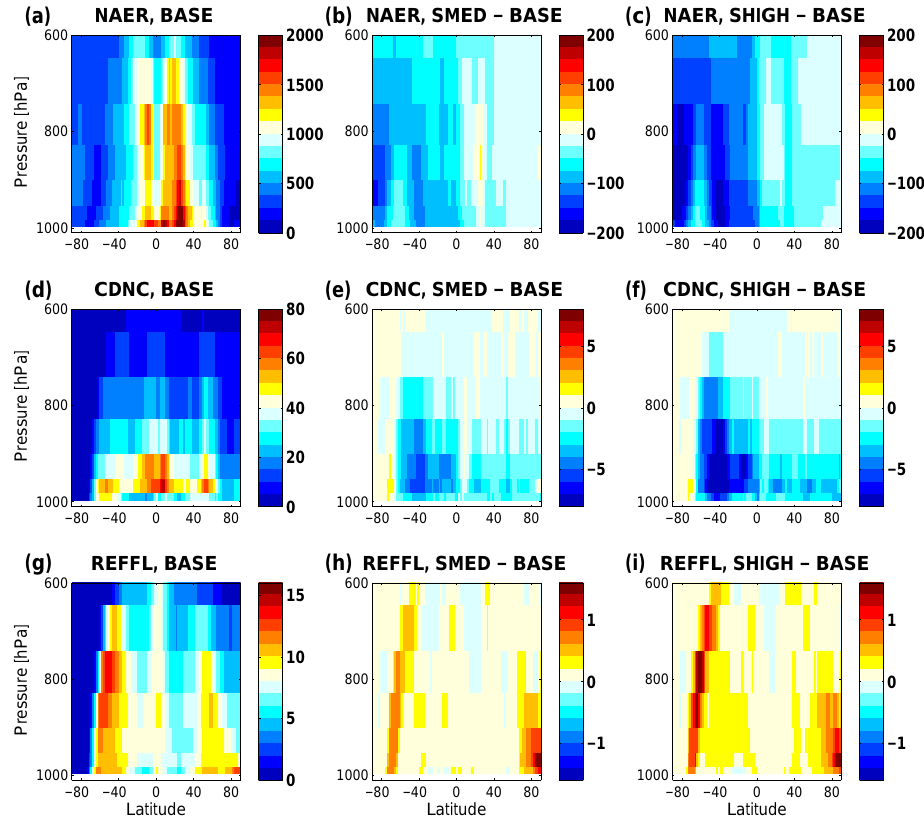
Figure 6. (a) Zonal mean aerosol number concentration ( N aer , cm − 3 ) averaged over the period 2171 to 2200 for the experiment BASE (no sensitivity of DMS production to pH), and (b, c) changes of N aer in the experiments SMED and SHIGH (relative to BASE). Panels (d) – (f) and (g) – (i) display corresponding plots for cloud droplet number concentration (CDNC, cm − 3 ) and effective radius of liquid cloud droplets ( R eff , µm).